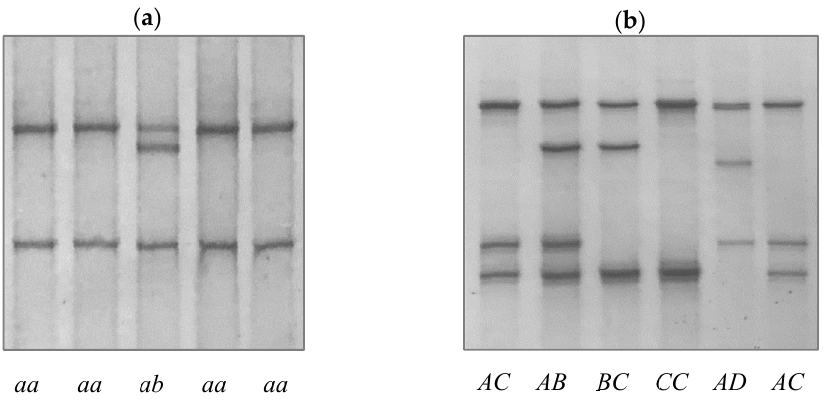
Figure 1. Sequence variants of bovine LPIN1 identified by PCR-SSCP analysis. Two variants ( a and b ) in the 5 ′ non-coding region ( a ) and four variants ( A to D ) in the sixth coding exon ( b ) are shown in either a homozygous or heterozygous form, with the genotypes being labelled under the corresponding banding patterns.